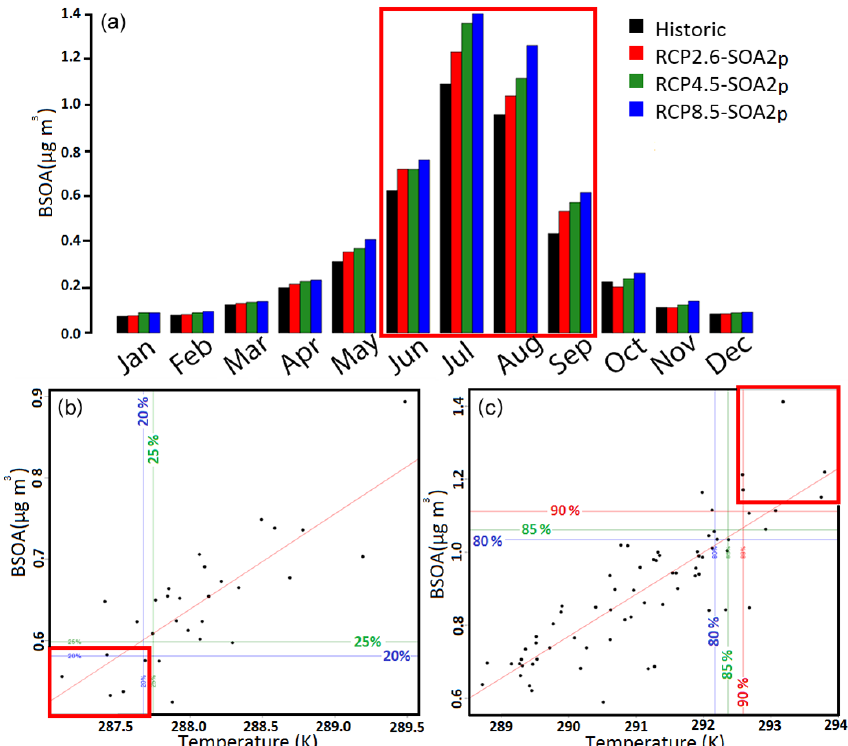
Figure 2. Monthly BSOA concentrations in different RCP scenarios, averaged over 70 years of simulations for future scenarios and 30 years for historic simulations (a) . BSOA for the June to September period highlighted in (a) was plotted against temperature, and years with the lowest temperature and lowest BSOA concentrations for historic simulations are shown in (b) . Those with the highest temperature and BSOA concentrations for future scenarios are shown in (c)